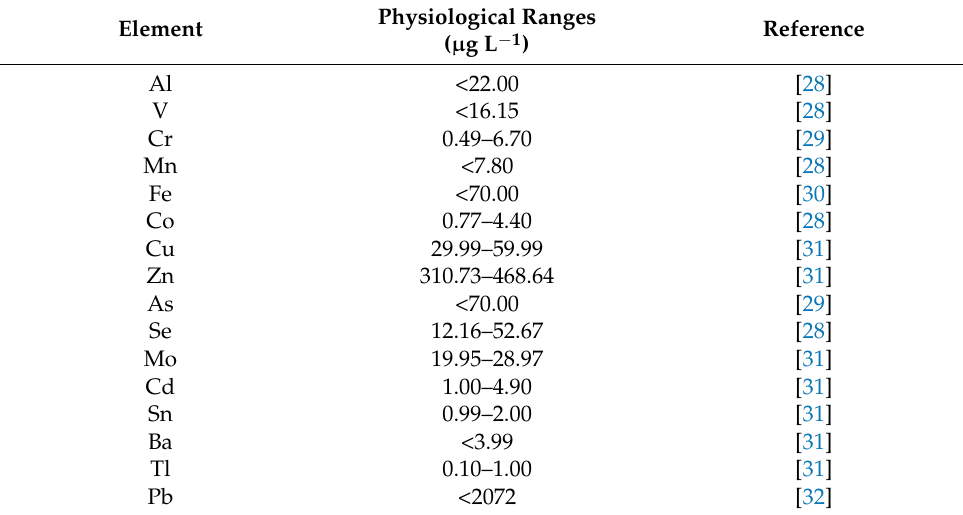
Table 1. Element concentration ranges that may be found in